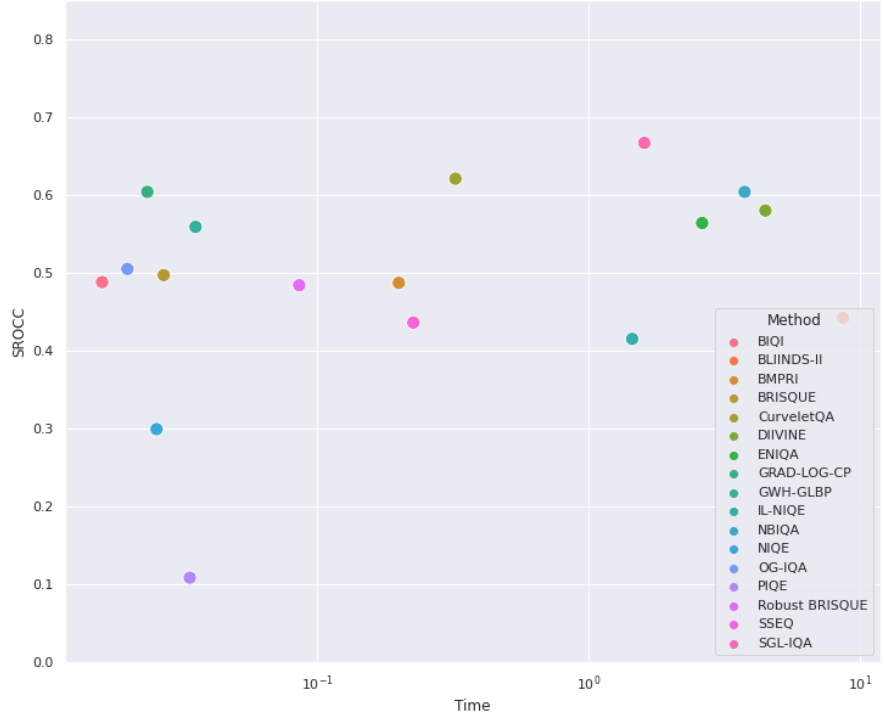
Figure 8. SROCC vs. feature extraction time (given in seconds on a logarithmic scale) based on the results obtained on CLIVE [10].